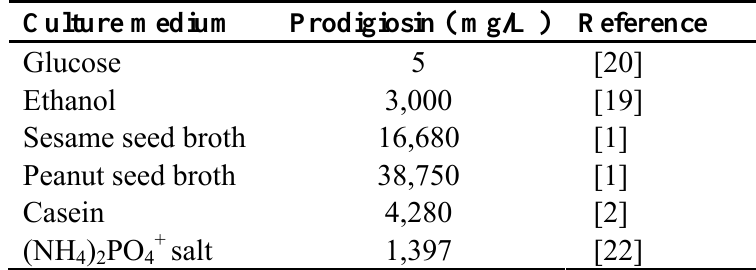
Table 2. Comparison of prodigiosin production by S. marcescens in different culture media.